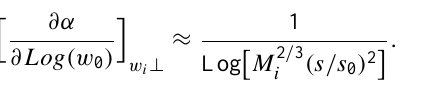
Fig. 15. Patterns in a plane w 0 − α of the apex and the mean perpendicular energy of H + ions. The format is the same as in Fig.